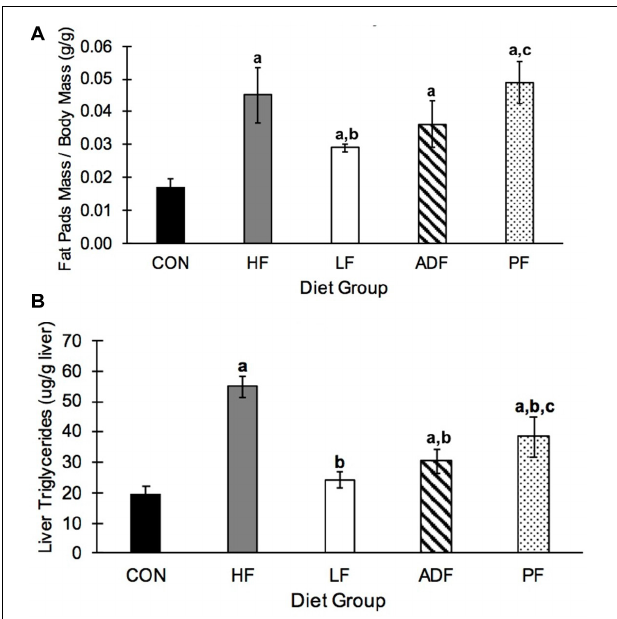
FIGURE 5 | Epididymal fat and hepatic triglycerides. (A) Average mass of both epididymal fat pads relative to body weight. CON mice had significantly smaller epididymal fat pads relative to BW compared to all other groups. In addition, the relative size of epididymal fat pads in the LF group were significantly smaller than those from HF and PF mice. (B) Liver triglyceride concentrations. HF liver triglyceride concentrations were triple that seen in CON mice. All diet regimens reduced this measure, with moving to a LF diet as the most effective. a: p < 0.05 vs. CON; b: p < 0.05 vs. HF; c: p < 0.05 vs. LF.